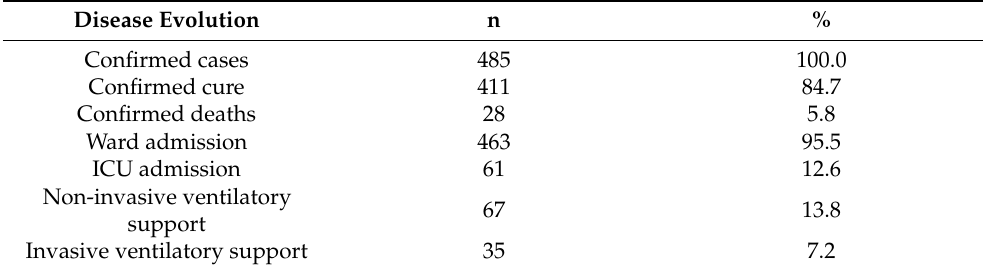
Table 1. Care profile of COVID-19 cases in pregnant and postpartum women. Ceara, Brazil, 2020. Disease Evolution n % Confirmed cases 485